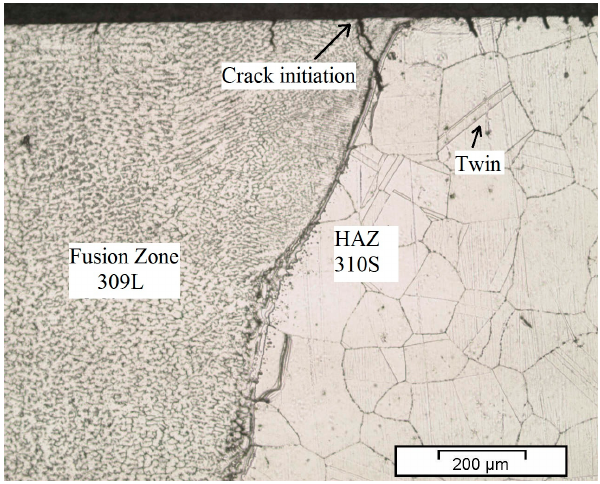
stainless steel. Note also cracks in the 309L weld metal.